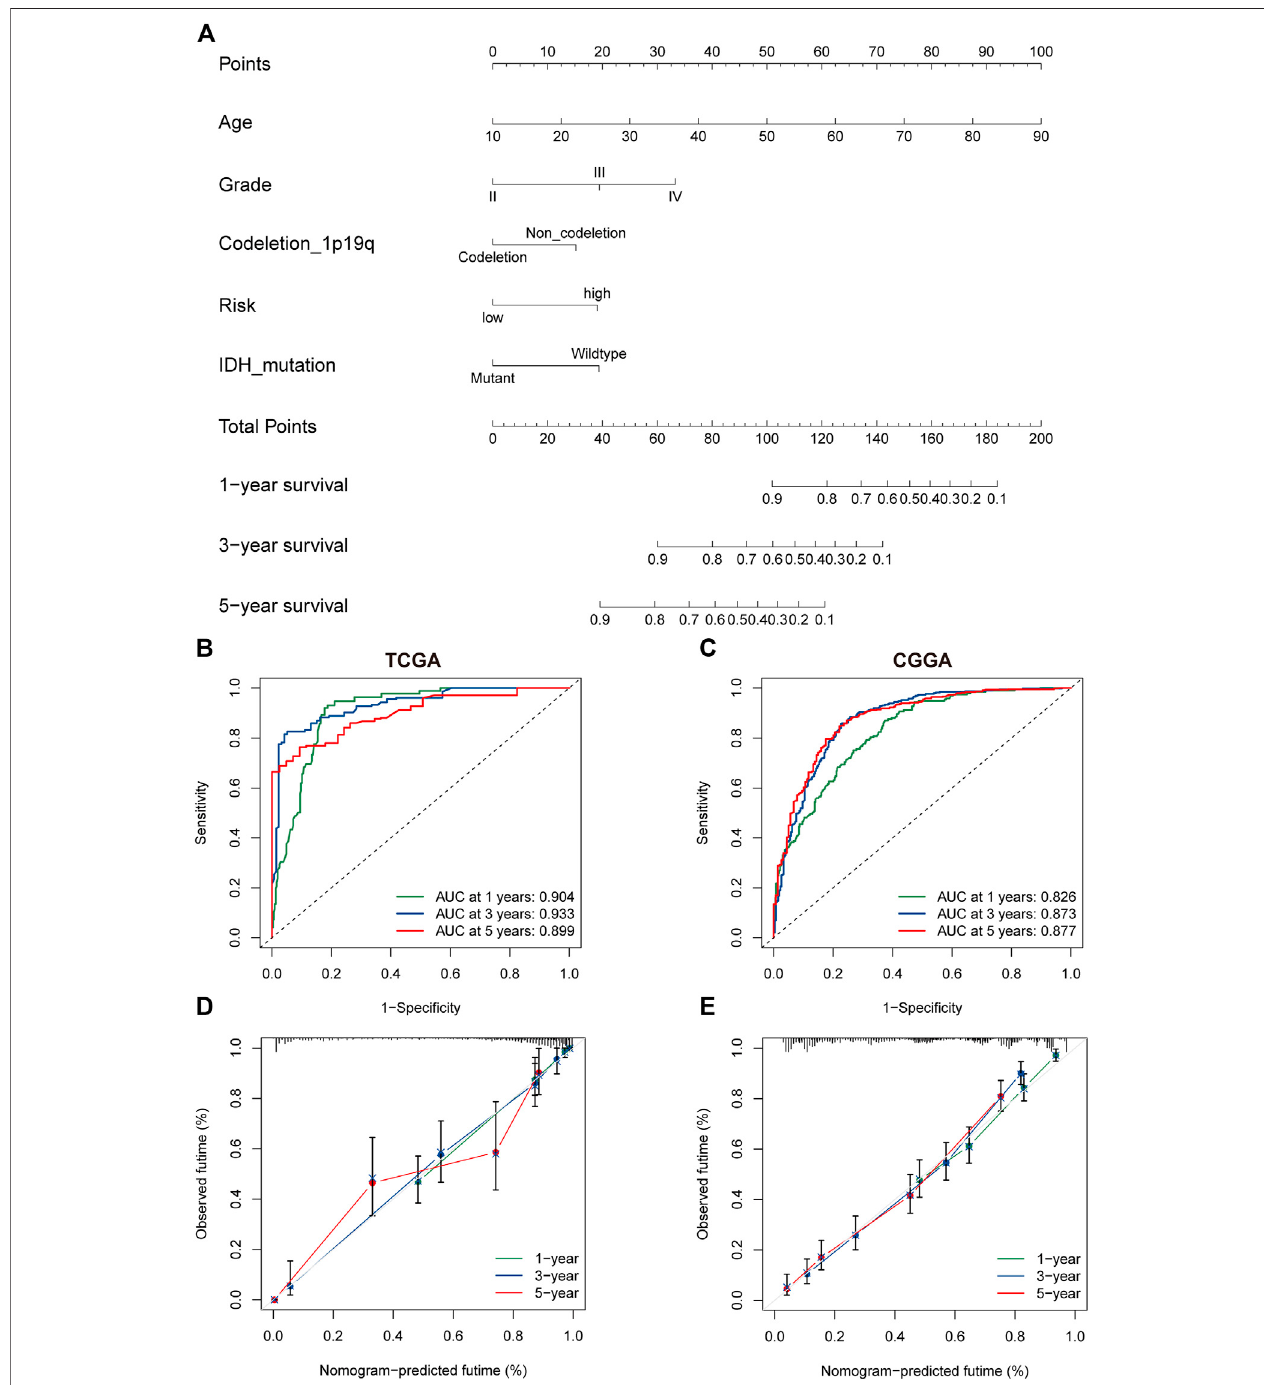
FIGURE6| ThenomogramofthePRGsignaturepredicts survivalinglioma patients. (A) ThenomogramwithPRGssignature riskgroup fortheprediction ofOSof glioma patients was constructed based on the TGGA dataset. BC. The time-dependent ROC analyses of the PRGs nomogram in TCGA (B) , and CGGA (C) . (D,E) The calibrationplotsforpredicting 1-,3-,and 5-yearsurvivalusing TCGA (D) ,and CGGA (E) .PRGs,Pyroptosis Related genes.TCGA,TheCancerGenomeAtlas. CGGA ， Chinese Glioma Genome Atlas.